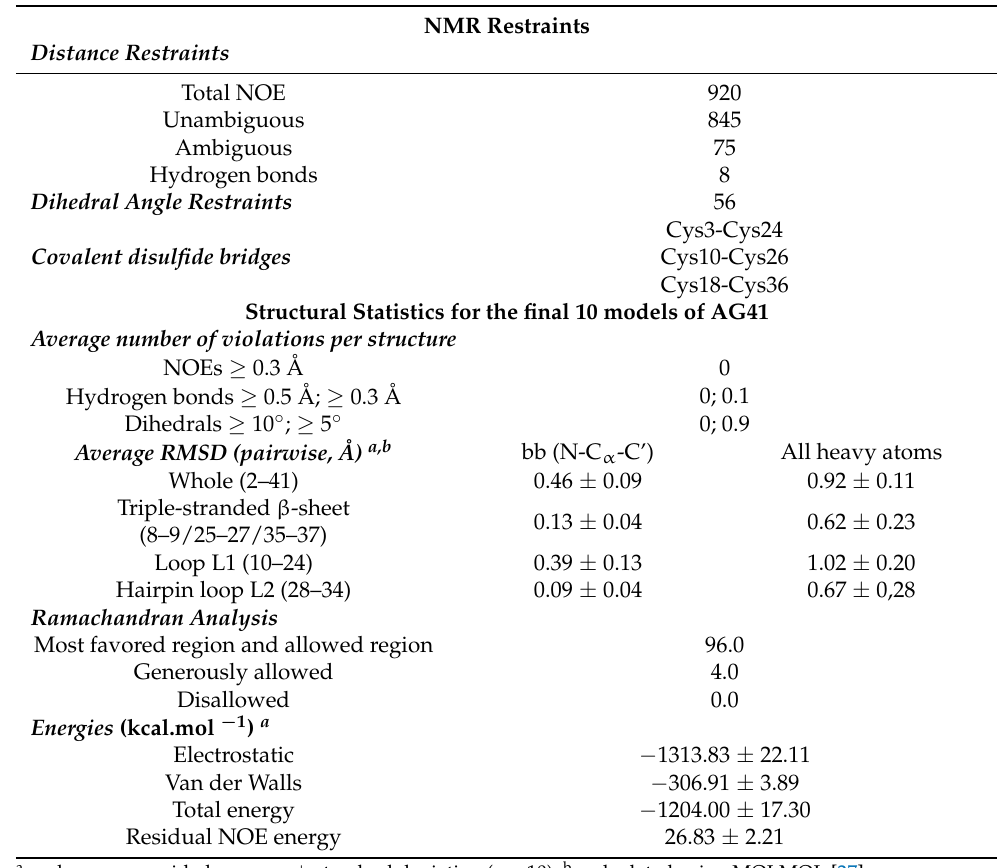
Table 1. NMR constraints and structural statistics.